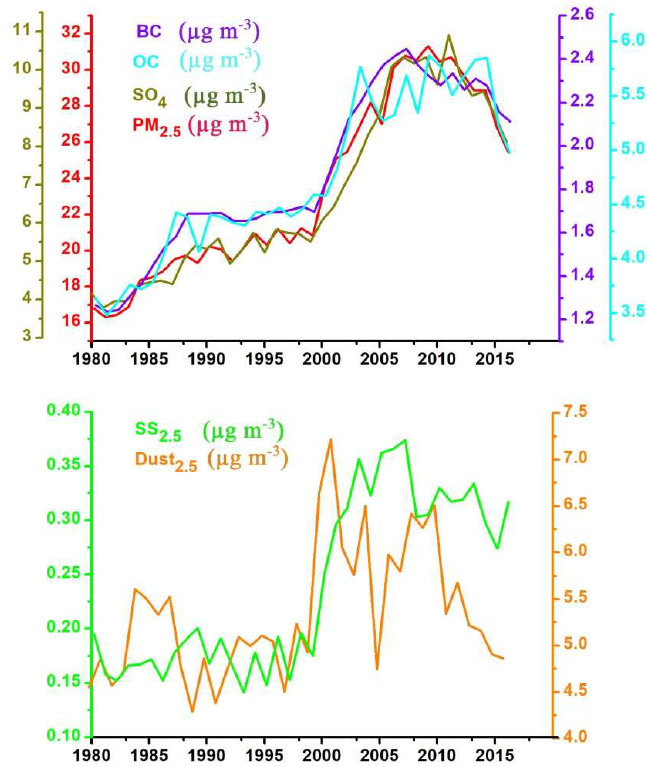
Figure 9. Annual mean trends in MERRA-2 PM 2.5 and its five major components over the YRB from µ g m − 3 1980 to 2017, in units of µg m -3 . 1980 to 2017, in units of